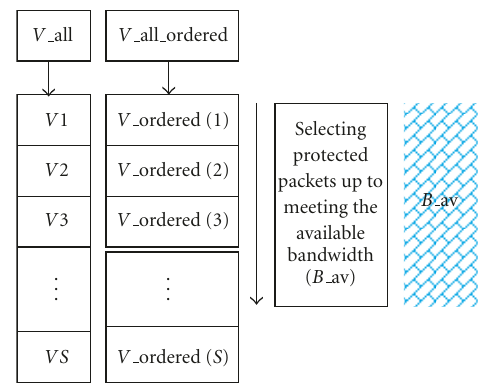
Figure 9: Gains selection by decreasing order of